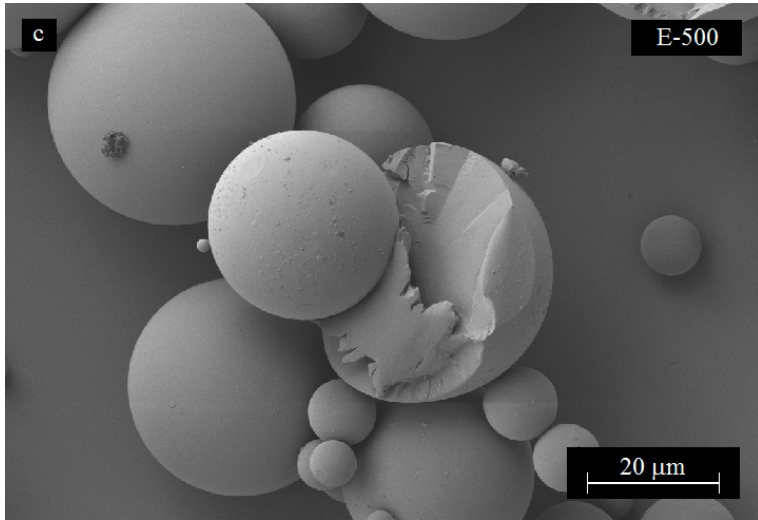
Figure 12. SEM micrographs showing additional shell and core morphological features observed on the prepared microcapsules.